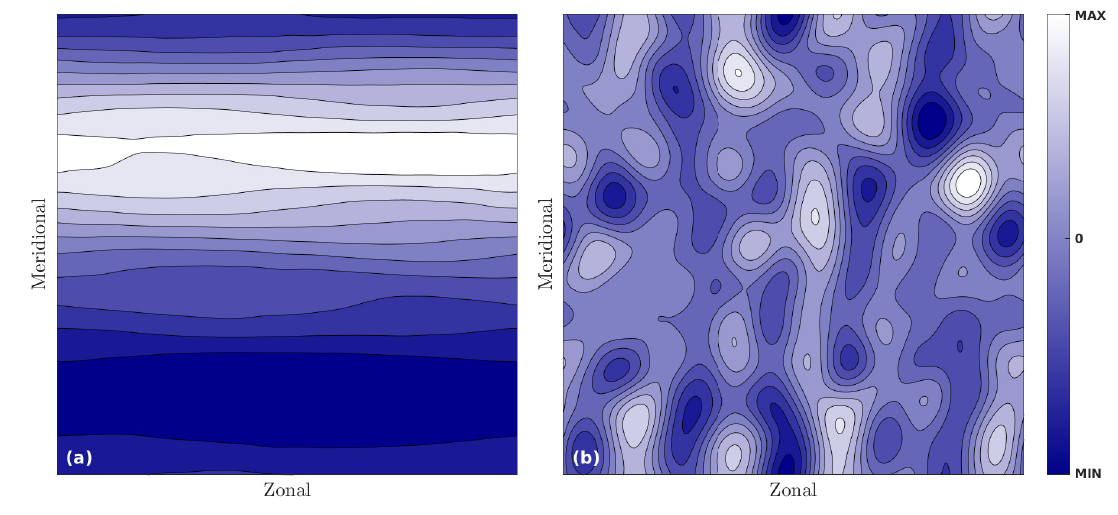
Figure 3. Contour lines of the ( a ) stream function ψ ( x , y ) and ( b ) magnetic potential A ( x , y ) for two-dimensional decaying magnetohydrodynamic (MHD) turbulence on the β -plane ( β = 25) as functions of x (zonal) and y (meridional). All contour lines are given for the time T =